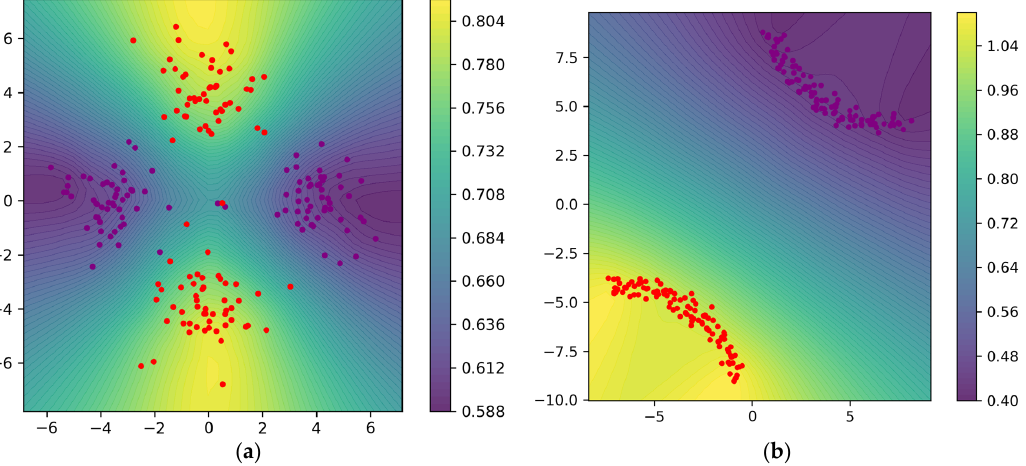
Figure 9. ( a ) Weight function values and contour lines evaluated on the mesh at epoch 0; the points from class 2 correspond to larger values. ( b ) Weight function values and contour lines evaluated on the mesh after 1800 epochs.